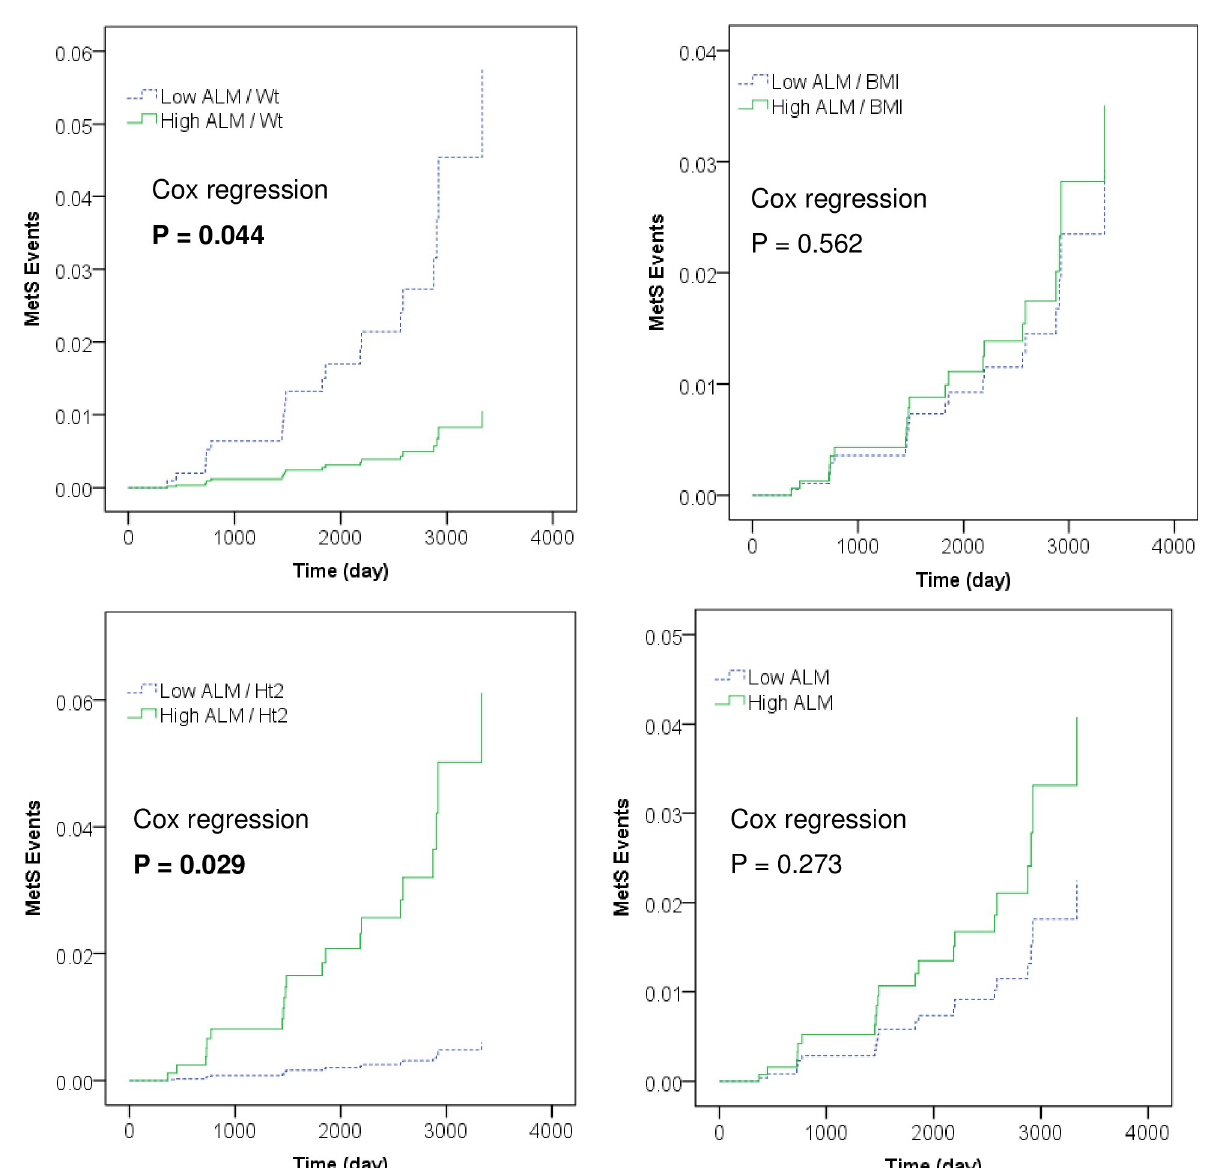
Fig 2. Cox proportional hazards model for events of incident metabolic syndrome (MetS). Bold green line shows High ALM indices group, and dashed blue line shows Low ALM indices group. Participants with low ALM/Wt showed significant association with an increased adjusted hazard ratio for MetS incidence compared with the participants with high ALM/Wt, after model 3 adjustment (see Table 4). In contrast, participants with high ALM/Ht2 showed significant association with an increased adjusted hazard ratio for MetS incidencecompared with the participants with low ALM/Ht2, after model 3